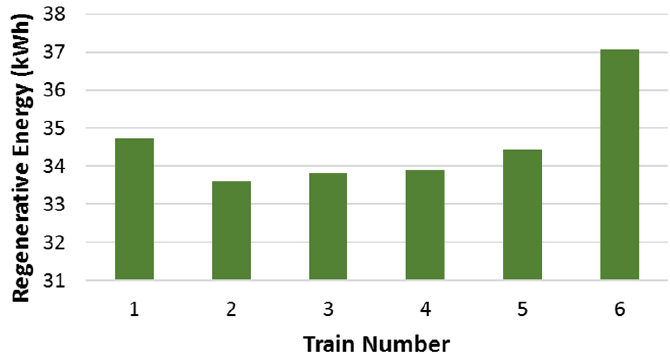
Figure 18. The regenerative energy of the trains running on a single track.